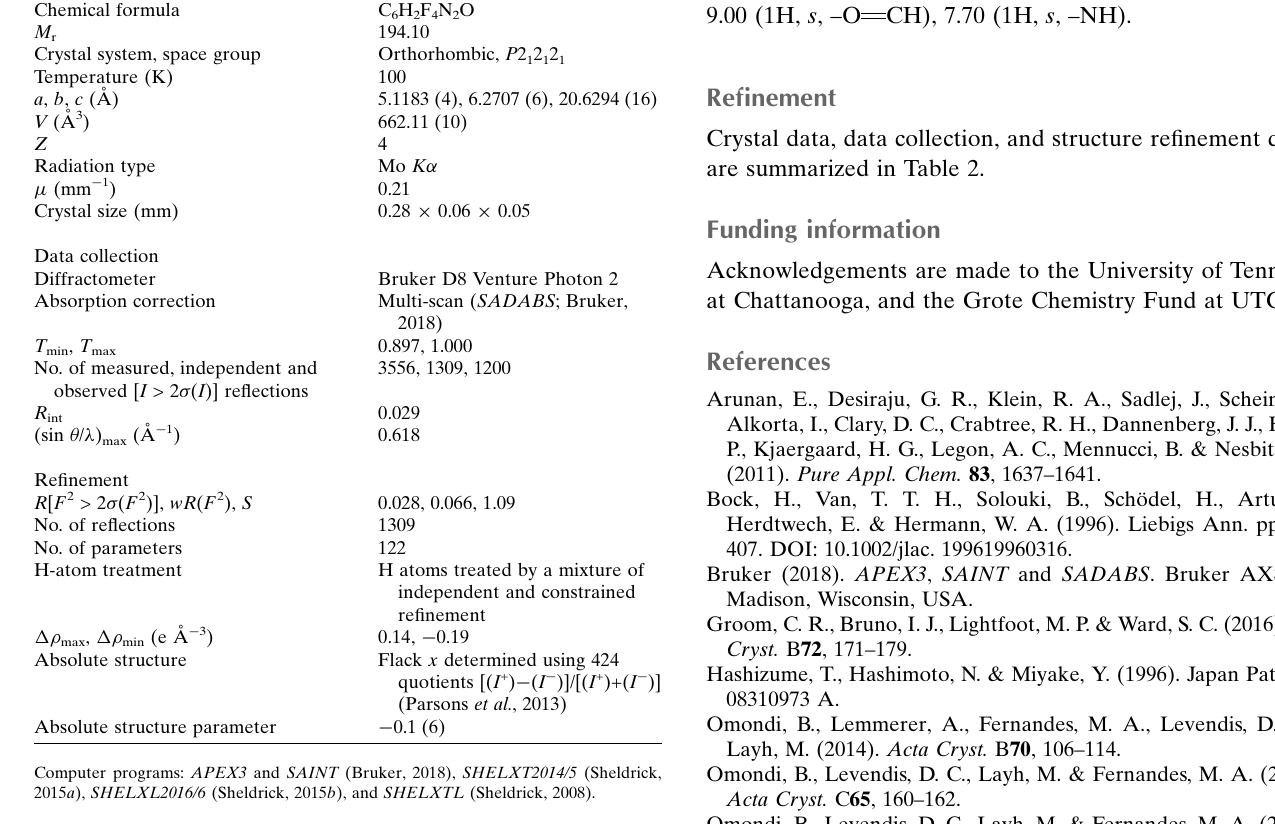
Table 2 Experimental details. Crystal data Chemical